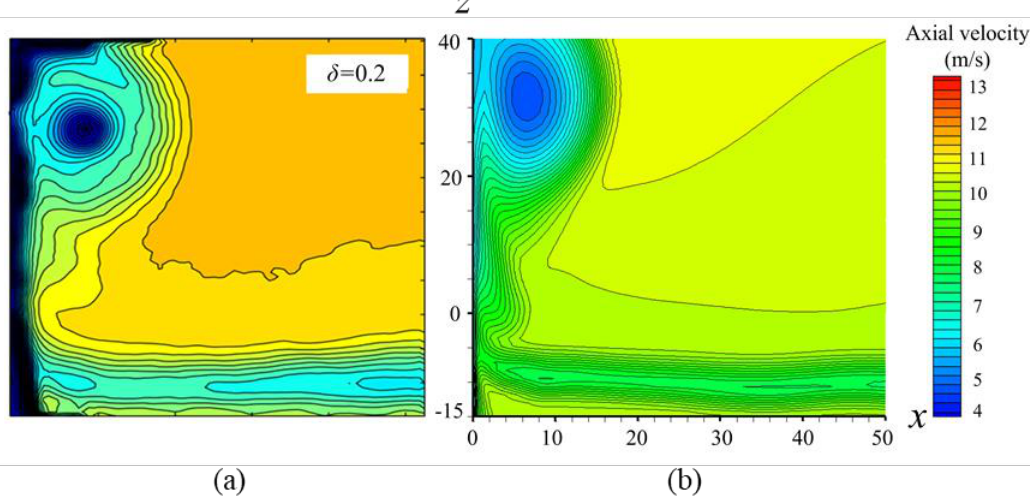
Figure 6. Comparison of the axial velocity contour at cut-plane of y / c = 1 between experiment [17] and numerical simulations. ( a ) Experimental results [17]; ( b ) Numerical results.